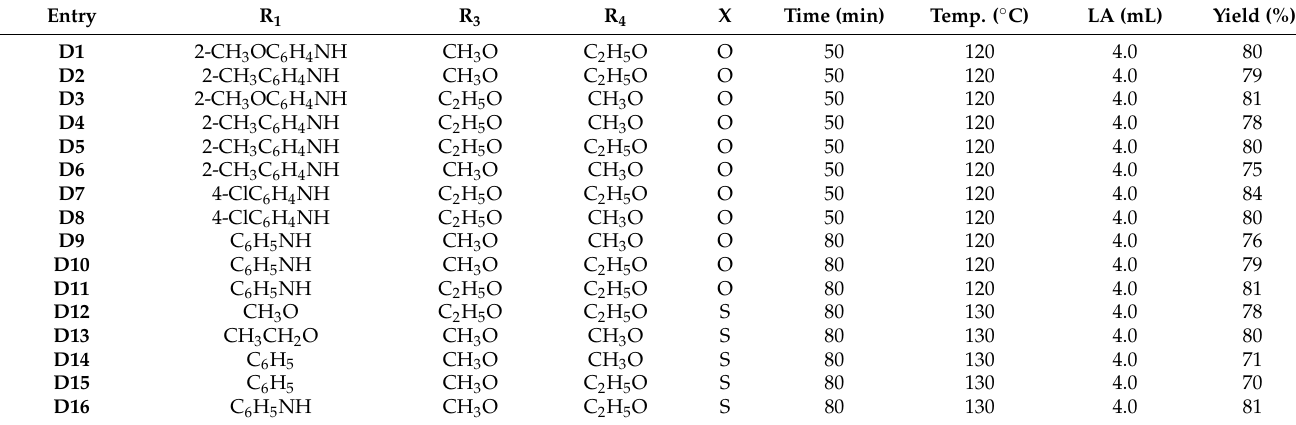
Table 2. Optimization of reaction conditions for solvothermal synthesis of dihydropyrimidinones ( D1 – D16 ) a .